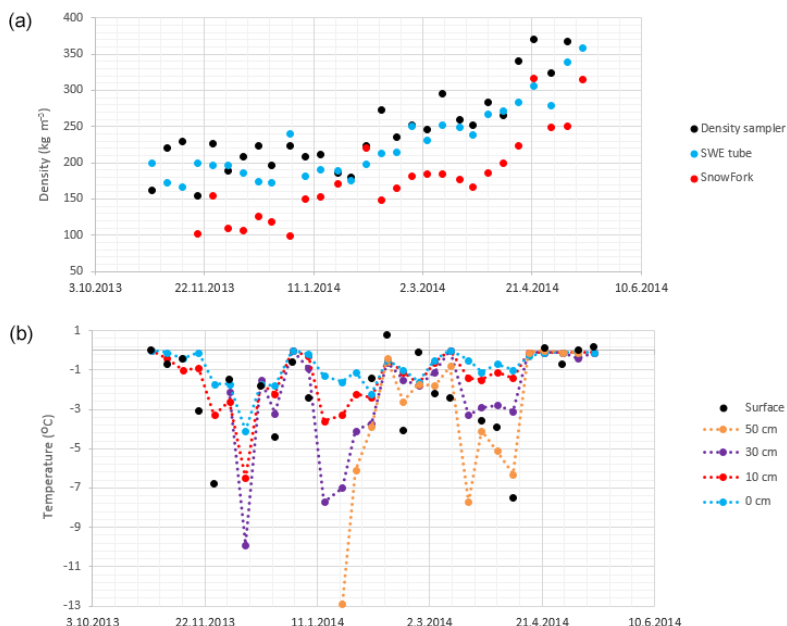
Figure 5. Example data from 2013 to 2014 snow pits at the IOA. (a) Densities from different instruments (average of density sampler profile, average of the SnowFork profile, and SWE tube). (b) Temperatures from different depths.